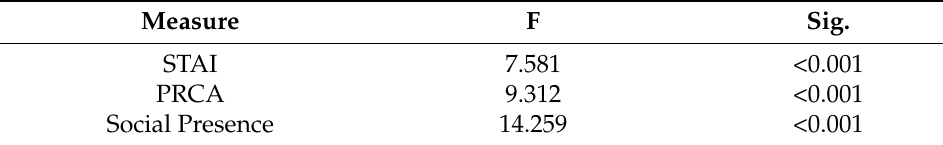
Table A1. ANOVA test result.